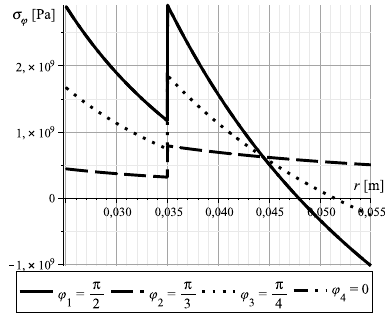
Figure 29: Plot of σ φ as a function of r for φ i ( i = 1 . . . 4) (Example 5.3).